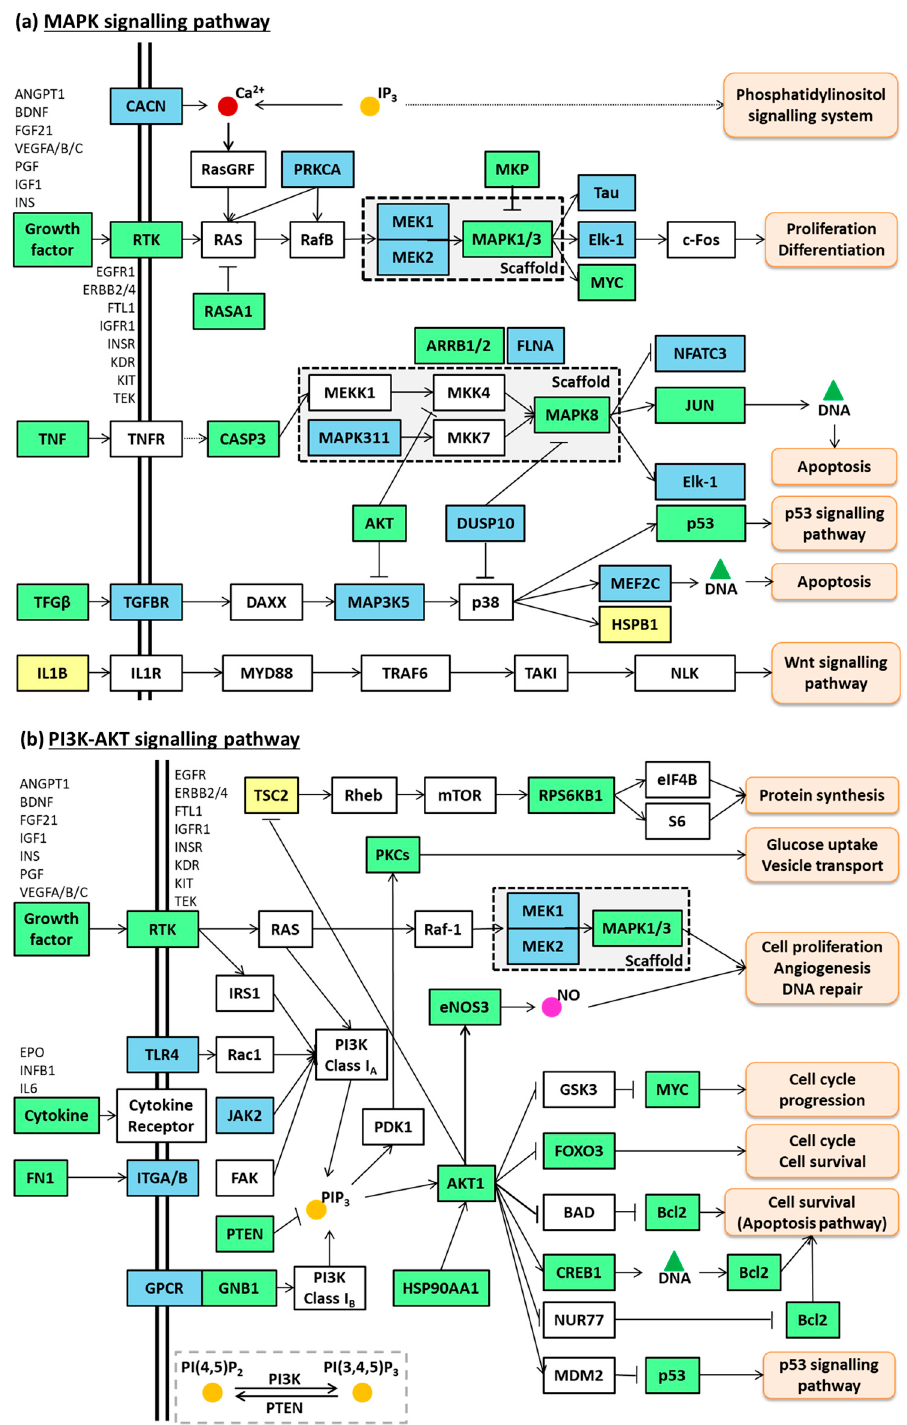
Figure 7. miR-107 and miR-139-5p common pathways. ( a ) MAPK signalling pathway. ( b ) PI3K-AKT signalling pathway. Coloured nodes correspond to target genes and their neighbouring genes. In blue: miR-139-5p target genes and their neighbouring genes; in yellow: miR-107 target genes and their neighbouring genes; in green: miR-139-5p and miR-107 common target genes and their neighbouring genes; in white: additional nodes for pathway completion. Unframed gene names correspond to targeted genes included under a broader category such as “growth factor”, “RTK” or “cytokine”. Adapted from pathways “MAPK signalling pathway (hsa04010)” and “PI3K-AKT signalling pathway (hsa04151)” generated in the KEGG database.